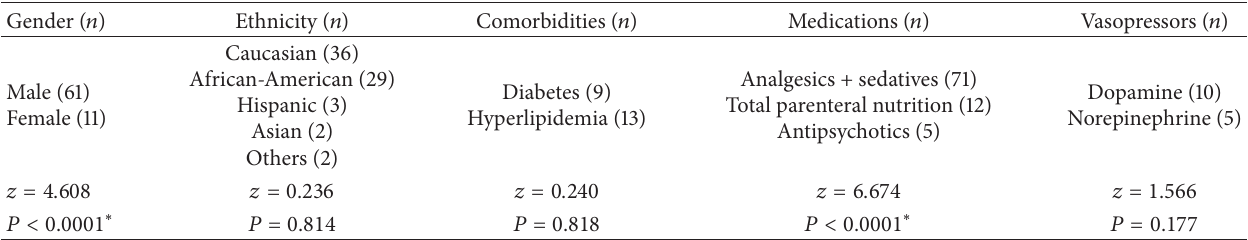
Table 1: Results: patient demographics ( 𝑁 = 72 ).